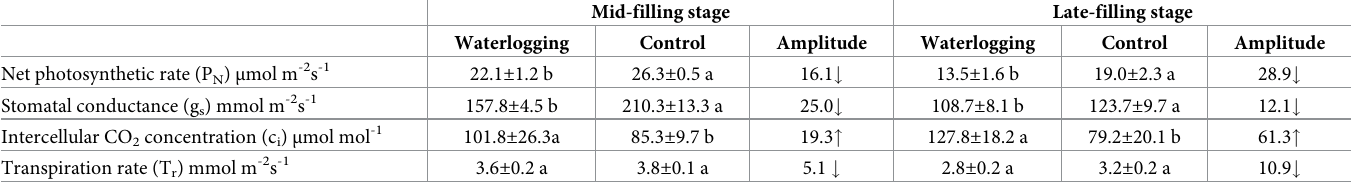
Table 2. Effects of waterlogging imposed at the seedling stage on photosynthetic capacity at the grain-filling stage (2015).